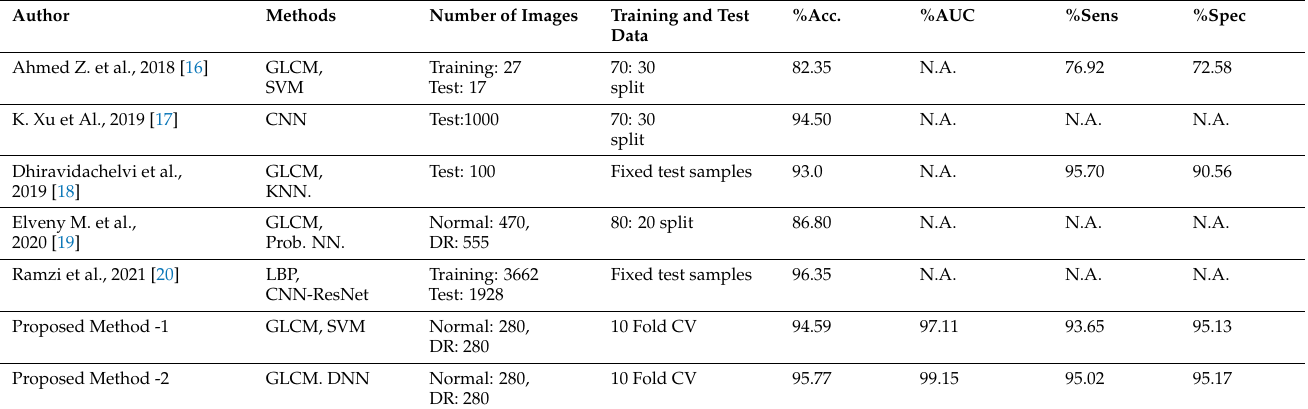
Table 4. Comparison of the proposed DR classifier with state-of-the-art